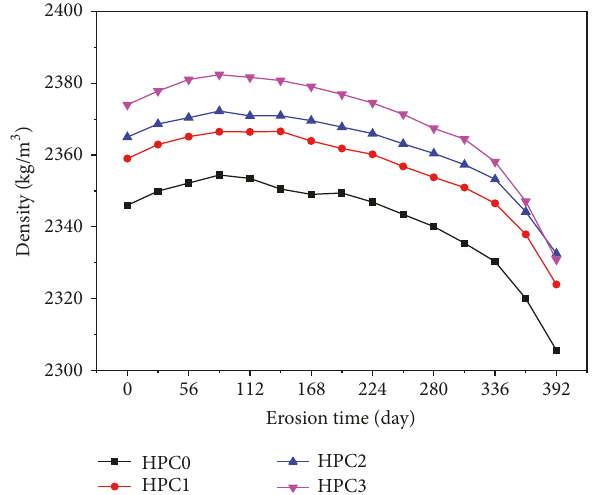
Figure 9: Density of HPCs at different erosion